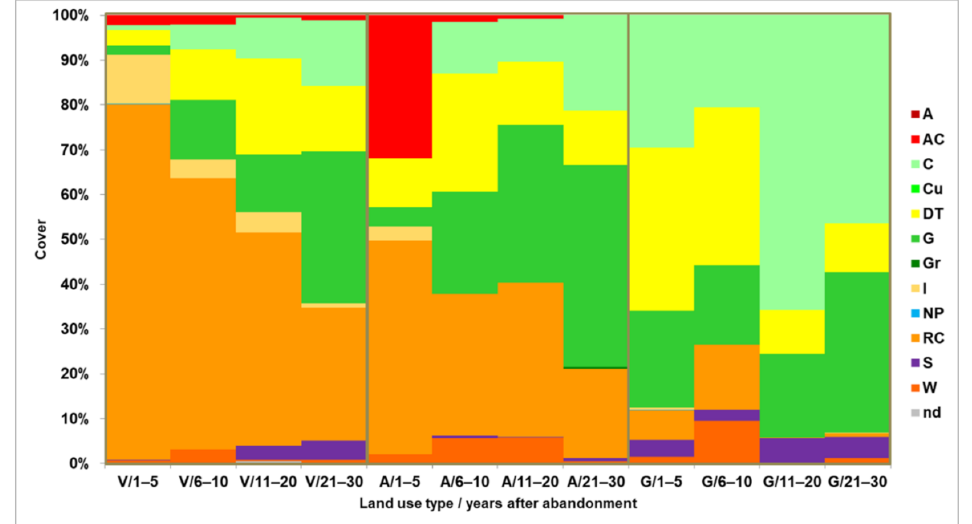
Figure 4. Distribution of naturalness (social behaviour types) in age groups of abandoned